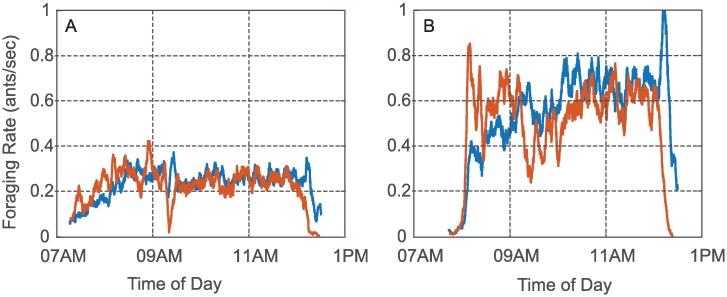
Plots of incoming foraging rate rin (blue) and outgoing foraging rate rout (red) versus time of day on August 20, 2016 for A) Colony 1357 and B) Colony 1317.The quasi steady-state (QSS) where incoming and outgoing rates equilibrated to a near-equal value can be observed for both colonies. The QSS rate for Colony 1317 was more than twice as great as it was for Colony 1357.